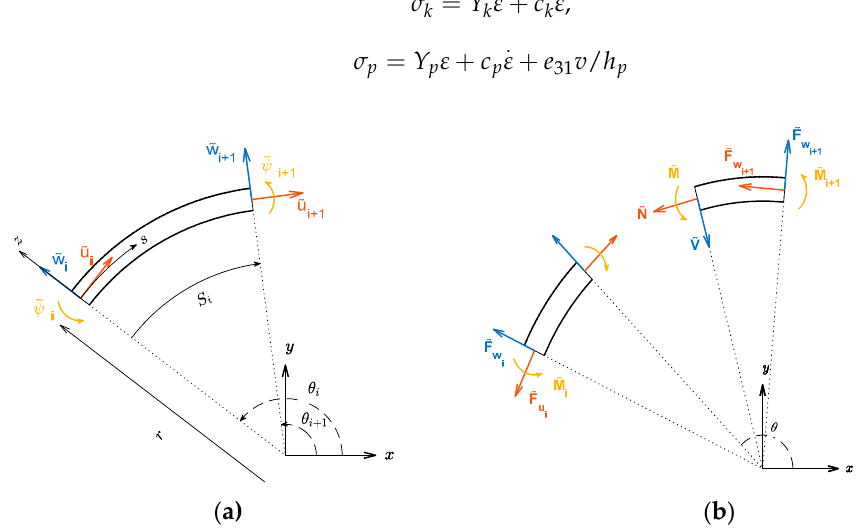
Figure 2. Dynamic stiffness analysis of segment of curved beam: (a) one element with nodal DOFs, local and global coordinate systems (b) element’s section with internal and external forces.